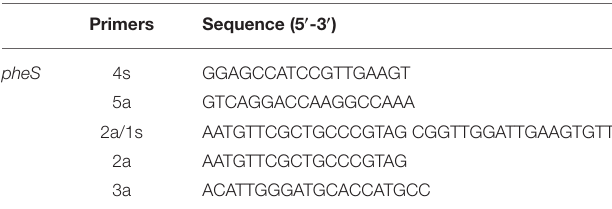
TABLE 1 | Primer sequences of CPA for